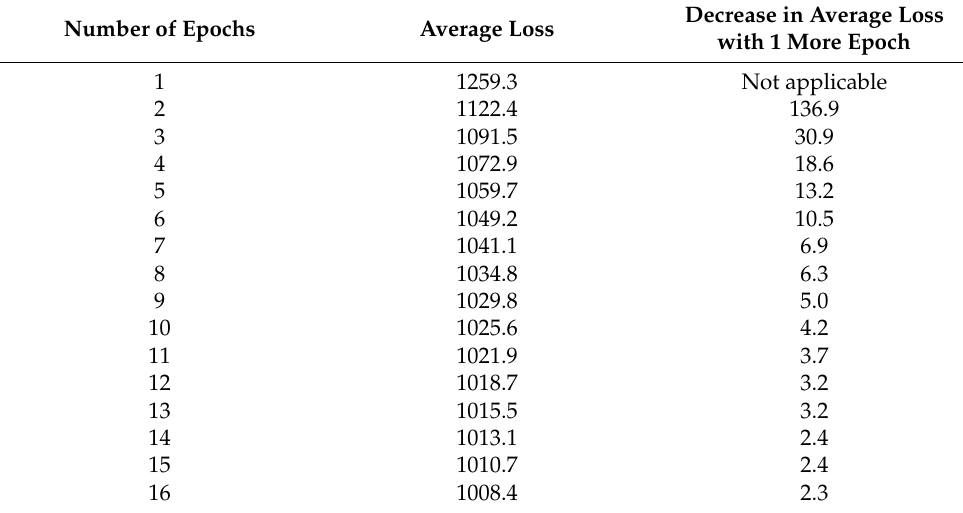
Figure 8. Average loss of the ten image-generation process vs. number of epochs in Case Study 1. Table 2. Statistical fi gures of average loss at di ff erent number of epochs within the VAE model.